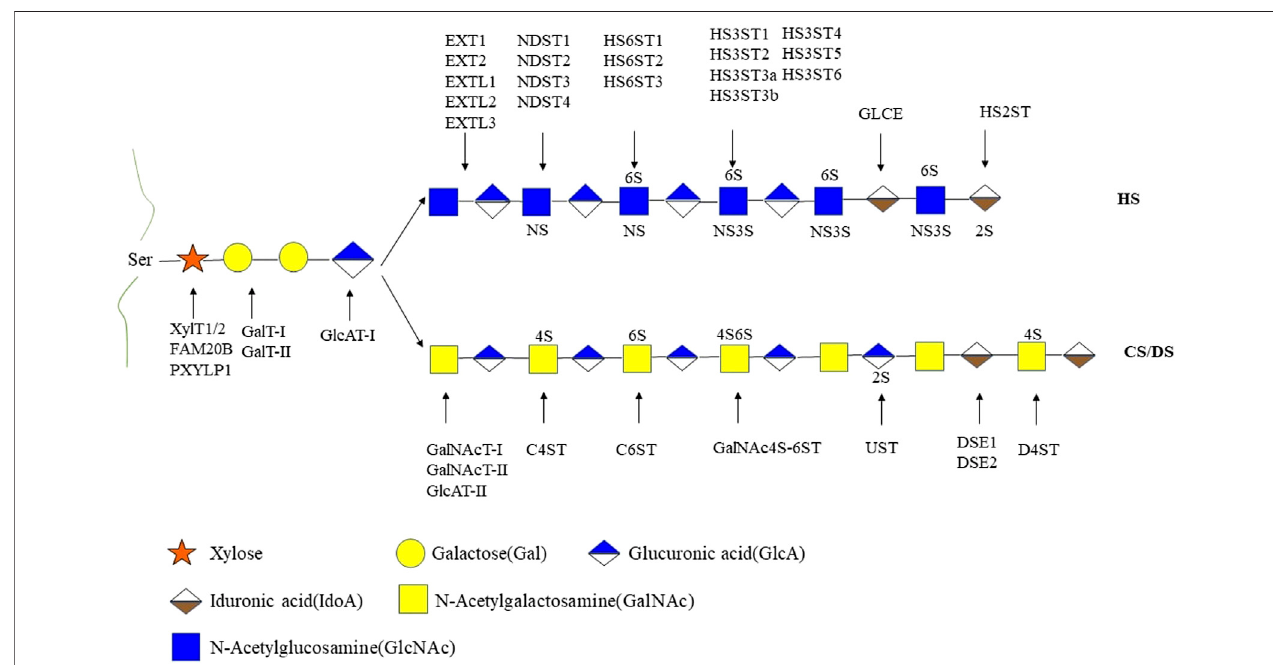
FIGURE 2 | The biosynthetic pathways of heparan sulfate and chondroitin sulfate/dermatan sulfate. HS, heparan sulfate; CS, chondroitin sulfate; DS, dermatan sulfate; 2S, 2-O-sulfation; 6S, 6-O-sulfation; 3S, 3-O-sulfation; 4S, 4-O-sulfation; NS, N-sulfated glucosamine. XylT1/2, xylosyltransferase 1/2; FAM20B, family with sequence similarity member 20-B; PXYLP1, 2-phosphoxylose phosphatase; GalT-I, galactosyltransferase-I; GalT-II, galactosyltransferase-II; GlcAT- Ⅰ , glucuronyltransferase- Ⅰ ; EXT1, exostosin glycosyltransferase 1; EXT2, exostosin glycosyltransferase 2; EXTL1, exostosin like glycosyltransferase 1; EXTL2, exostosin like glycosyltransferase 2; EXTL3, exostosin like glycosyltransferase 3; NDST1, N-sulfotransferase; NDST2, N-sulfotransferase 2; NDST3, N-sulfotransferase 3; NDST4, N-sulfotransferase 4; HS6ST1, heparan sulfate 6-O-sulfotransferase 1; HS6ST2, heparan sulfate 6-O-sulfotransferase 2; HS6ST3, heparan sulfate 6-O- sulfotransferase 3; HS3ST1, heparan sulfate 3-O-sulfotransferase 1; HS3ST2, heparan sulfate 3-O-sulfotransferase 2; HS3ST3a, heparan sulfate 3-O-sulfotransferase 3a; HS3ST3b, heparan sulfate 3-O-sulfotransferase 3b; HS3ST4, heparan sulfate 3-O-sulfotransferase 4; HS3ST5, heparan sulfate 3-O-sulfotransferase 5; HS3ST6, heparan sulfate 3-O-sulfotransferase 6; GLCE, C-5 epimerase; HS2ST, heparan sulfate 2-O-sulfotransferase; GalNAcT- I, GalNAc transferase-I; GalNAcT- IIs, GalNAc transferase-II; GlcAT- II, β 1,3-glucuronyltransferase- II; C4ST, chondroitin 4-O-sulfotransferase; C6ST,; GalNAc4S-6ST,; UST, uronyl 2-O-sulfotransferase; DSE1, DS epimerase1; DSE2, DS epimerase2; D4ST, dermatan 4-O-sulfotransferase; GalNAc4S-6ST, GalNAc 4-sulfate 6-O-sulfotransferase. Monosaccharides in this fi gure are represented in accordance with the symbol nomenclature for glycans (SNFG) (Varki et al., 2015).